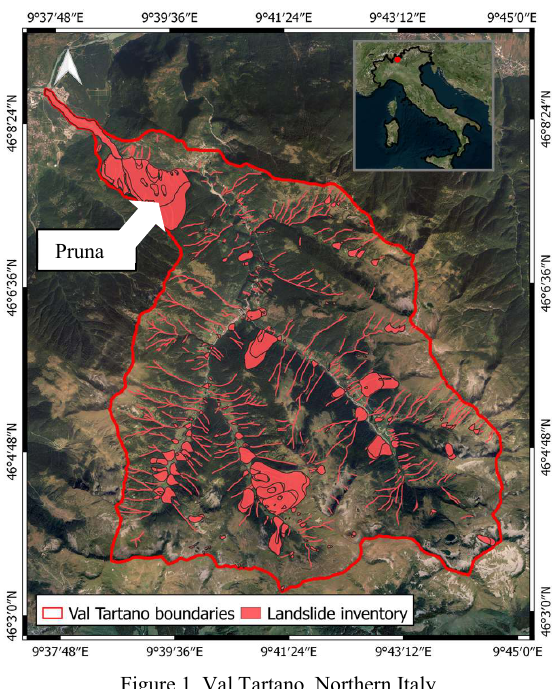
Figure 1. Val Tartano, Northern